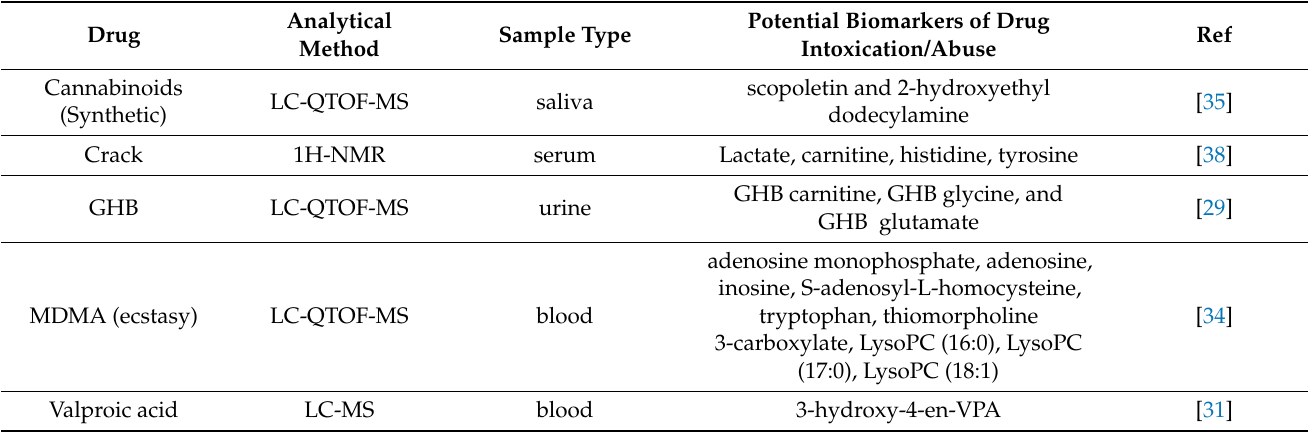
Table 1. Summary of studies using metabolomic analysis to detect metabolites as the potential biomarkers of drug intoxication/abuse in human